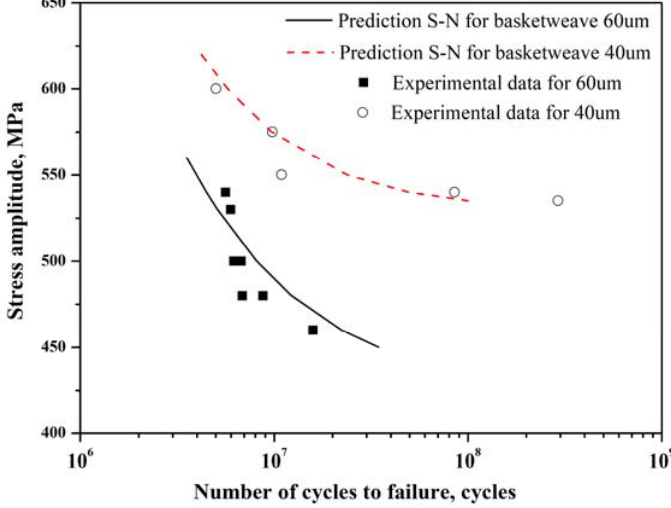
Figure 9. Comparison of the predicted fatigue life with different basketweave size versus the experimental data.